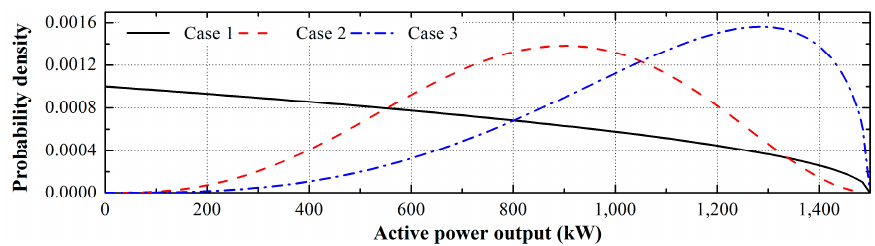
Figure 10. PDFs for the active power output of the DG.